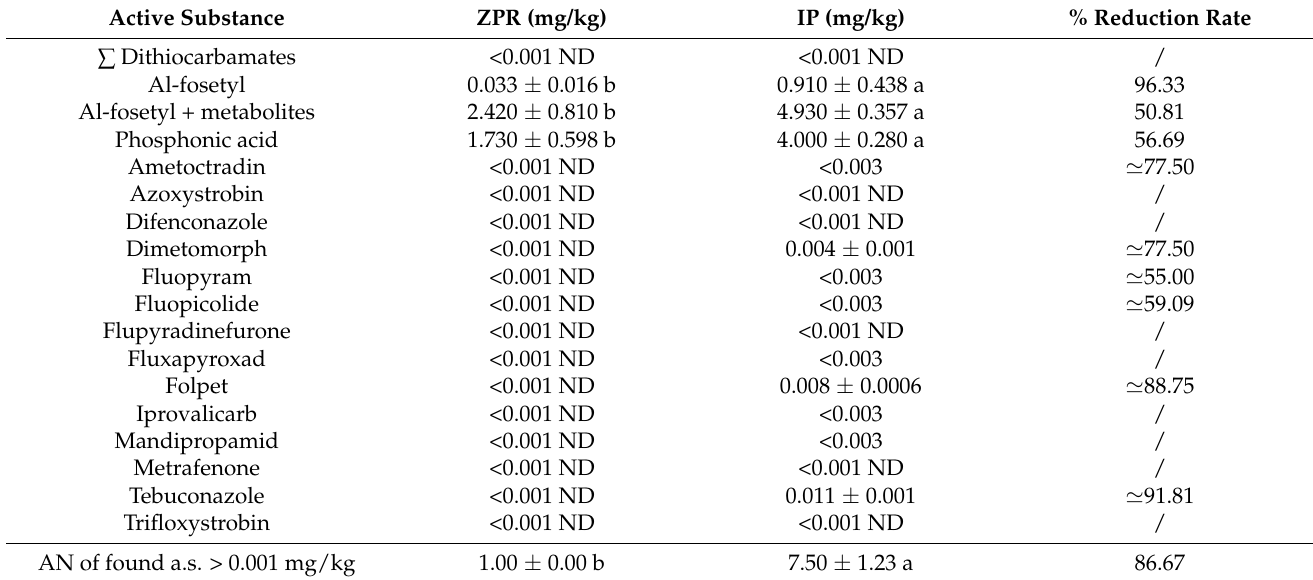
Average concentration (mean ± SE) of pesticide residues in Sauvignon wine. Result < 0.001 ND means a.s. was not detected at a level higher than 0.001 mg kg − 1 . /—concentration reduction rate and significance of difference between IP (integrated) and ZPR (0-pesticide residue) means cannot be calculated. Pesticide concentration reduction rate (%) = 100 − ((ZPR/IP) × 100) (see explanation in Section 2.4).